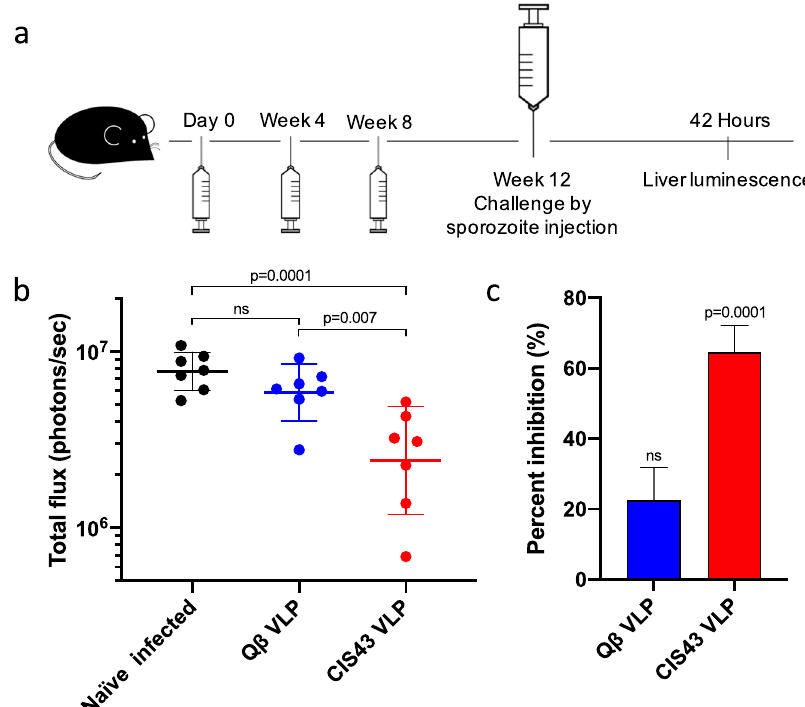
Fig. 3 Immunization with CIS43 VLPs without exogenous adjuvant confers partial protection from Plasmodium infection. a Immunization and challenge scheme. b Parasite liver load (as measured by luminescence) in vaccinated or naive C57BL/6 mice following challenge by sporozoite injection. Horizontal lines represent the geometric mean luminescence of each group, error bars represent SD of the geometric mean. Baseline luminescence was measured at 10 5 photons/s. Groups were compared statistically using one-way ANOVA followed by Dunnett ’ s multiple comparison test. ns; not signi fi cant. c Percent inhibition of liver infection, as calculated from luminescence data shown in b . Inhibition of infection is calculated relative to the mean signal in the naive, challenged group of mice. Mann – Whitney test was used to statistically compare each group to the naive infected control group. Error bars represent